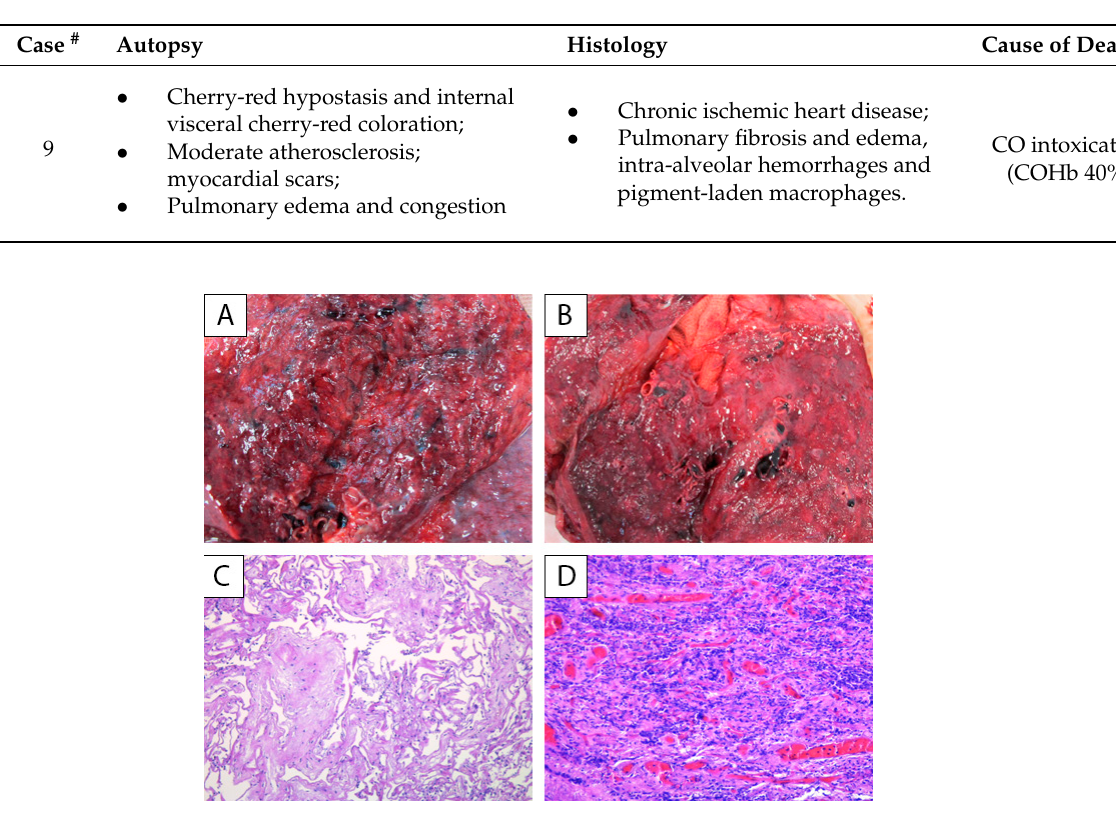
Figure 1. Group A: lung macroscopic and microscopic findings: ( A , B ) cut surface showing the consolidation of lobes and red congested areas, with thickening of the interstitial septa and pulmonary edema; ( C ) interstitial fibrosis H&E, 200×; ( D ) numerous inflammatory cells consisting mostly of lymphocytes infiltrating into alveolar septa and clustering around capillary vessels, H&E, 200×.